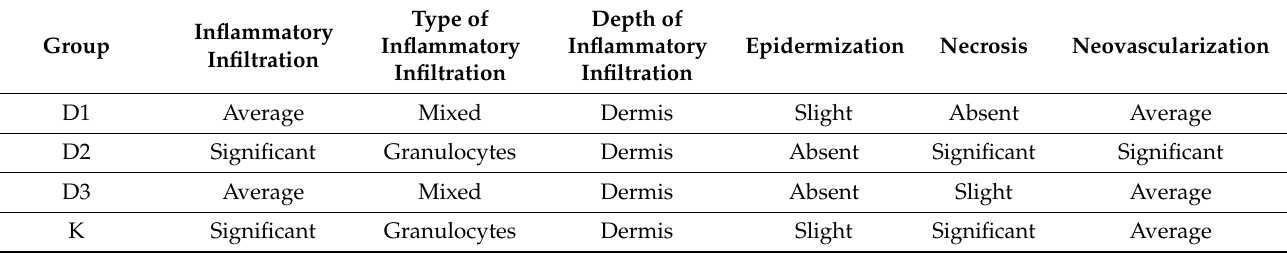
Table 10. Histopathological results from day 15.